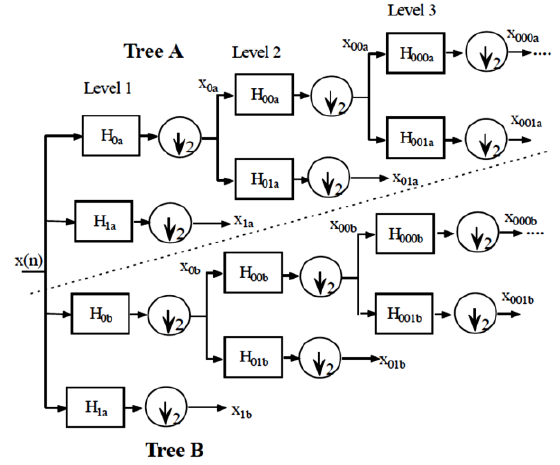
Fig. 4. The three level dual-tree complex wavelet transform.